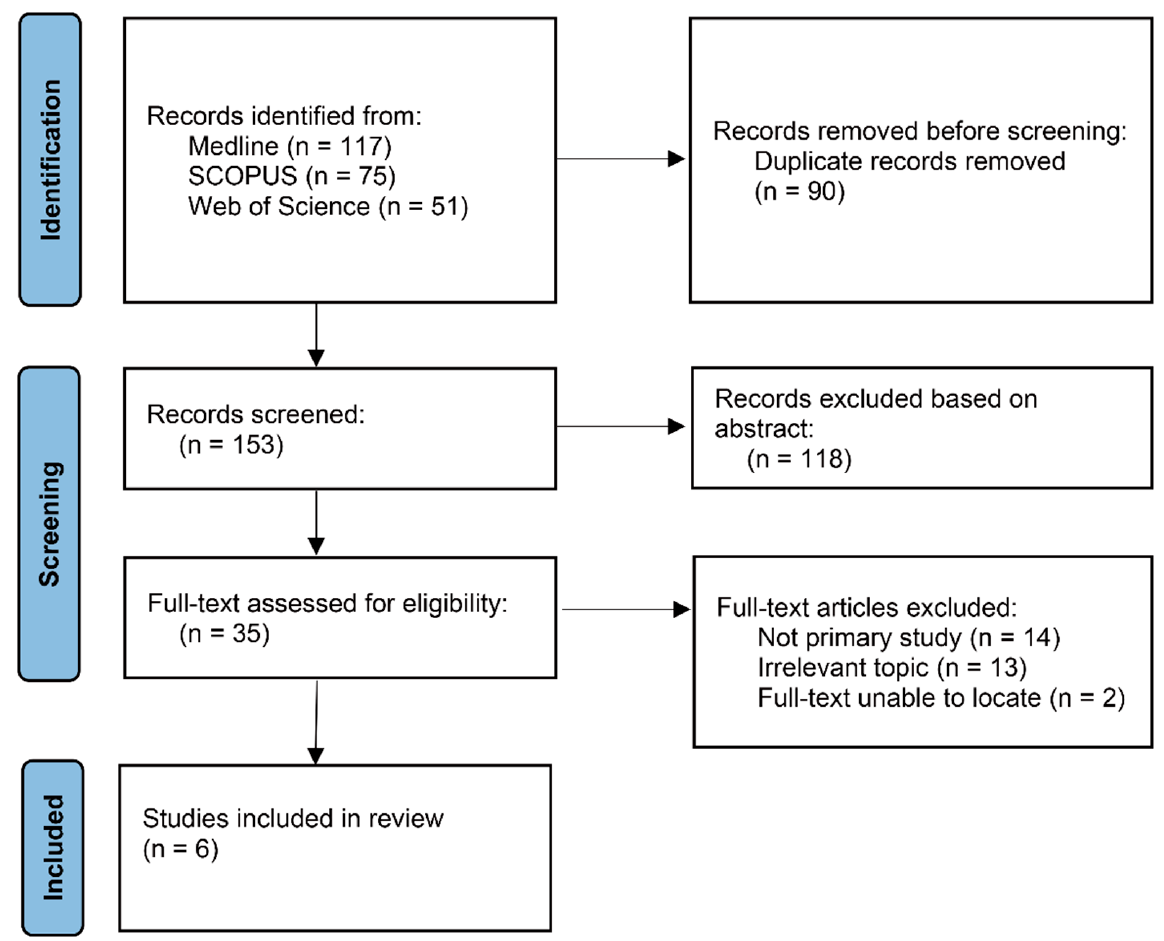
Figure 1. Flow Diagram of Study Selection.